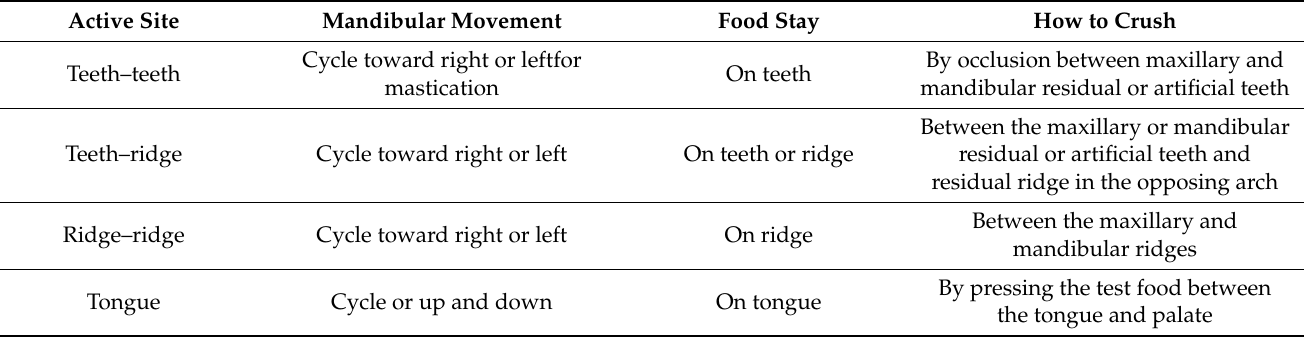
Table 1. Definition and classification of active site by visual